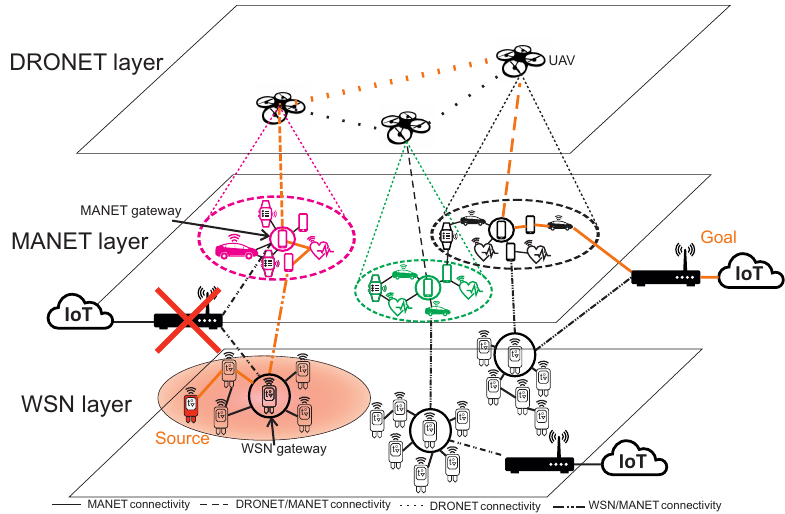
Figure 1. Structure of